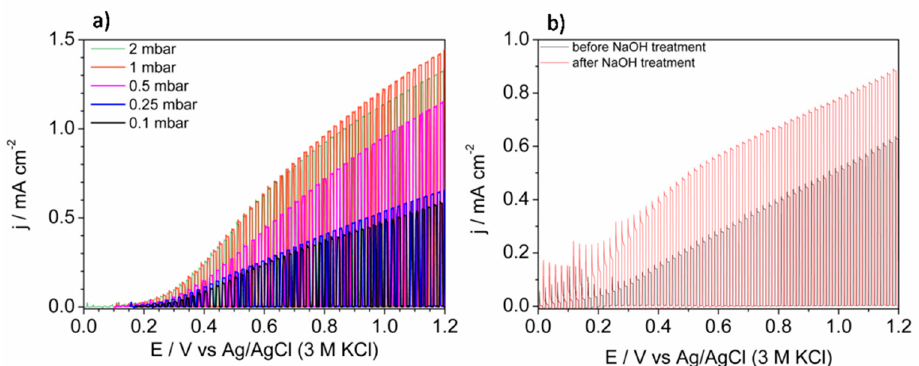
Figure 9. ( a ) The comparison of LSV curves recorded in 0.2 M K 2 SO 4 under intermittent AM 1.5 illumination for FTO/BiVO 4 photoanodes deposited under various oxygen pressures. ( b ) The comparison of LSV curves recorded for FTO/BiVO 4 photoanodes (0.1 mbar) before and after NaOH treatment. Scan rate was 20 mV s -1 .